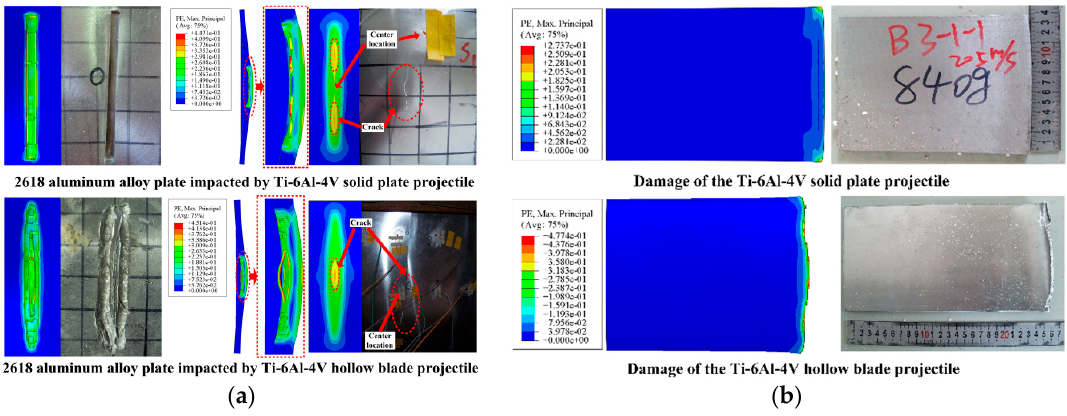
Figure 9. ( a ) Damage morphologies of the 2618 aluminum alloy plates impacted by the Ti-6Al-4V solid plate projectiles and hollow blade projectiles; and ( b ) damage morphologies of the Ti-6Al-4V solid plate projectile and the hollow blade projectile.